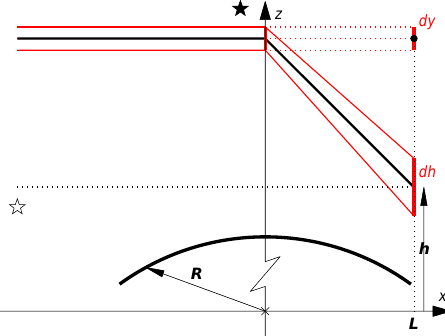
Figure 3. The refractive dilution mechanism for a pointlike distant